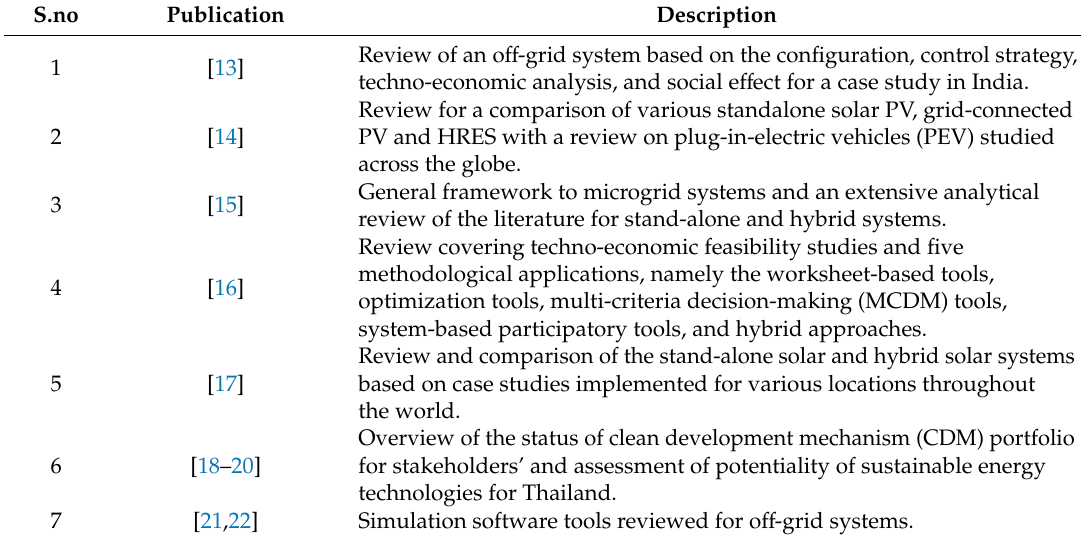
Table 1. Review publications for o ff -grid